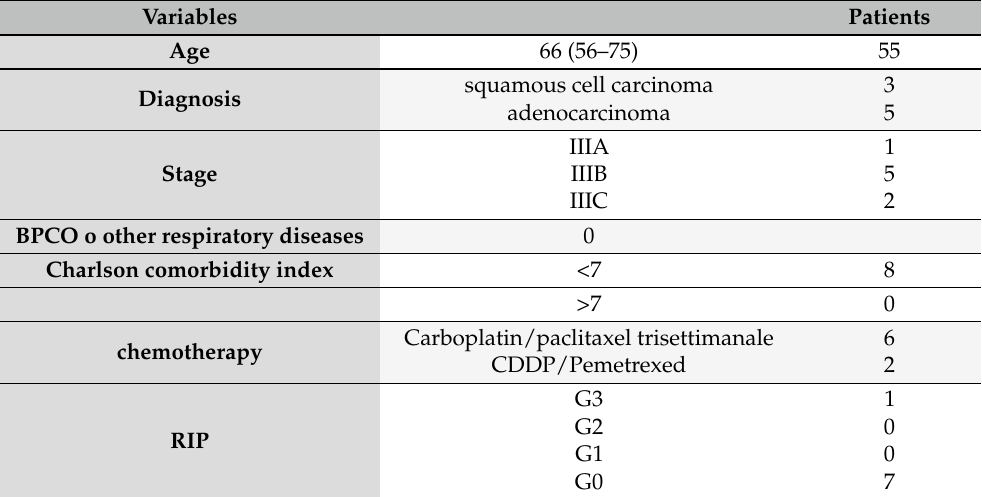
Table 1. Patient and treatment characteristics.